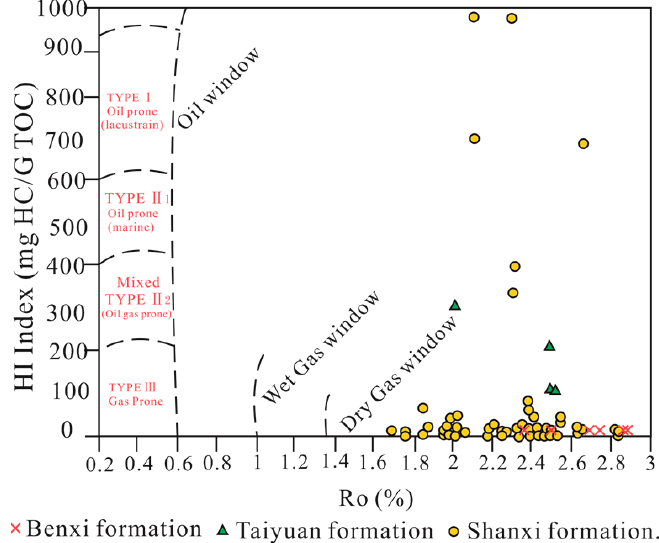
Figure 8. A plot of HI versus R O displaying the type and maturity of samples. Variations of calculated vitrinite reflectance isoline, along longitudinal and horizon- tal directions, are regular by the thermal evolution of the Fuxian and Yanchang regions (R O > 3.0%), while in the south, they are relatively high and gradually reduce to the sur- rounding values shown in Figure 7. The values of R O in this area generally reached the postmature-dry gas stage (R O > 2.0%). It is worth mentioning that variations of thermal evolution and TOC showed a contrary trend of the thickness to mudstones and coals, which suggest that the thickness of source rock is not directly correlated to hydrocarbon generation